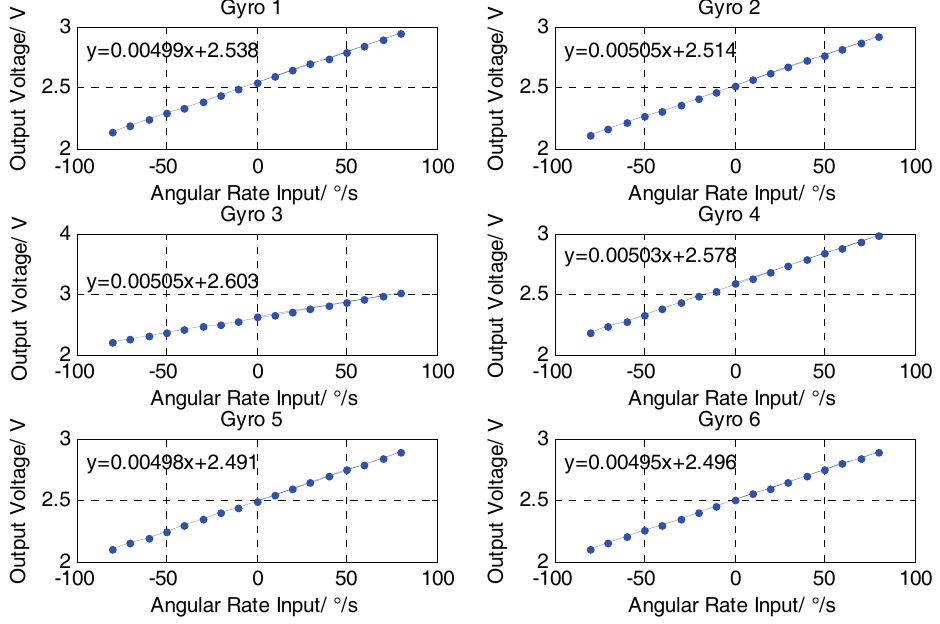
Figure 2. Scale factor plot of the individual